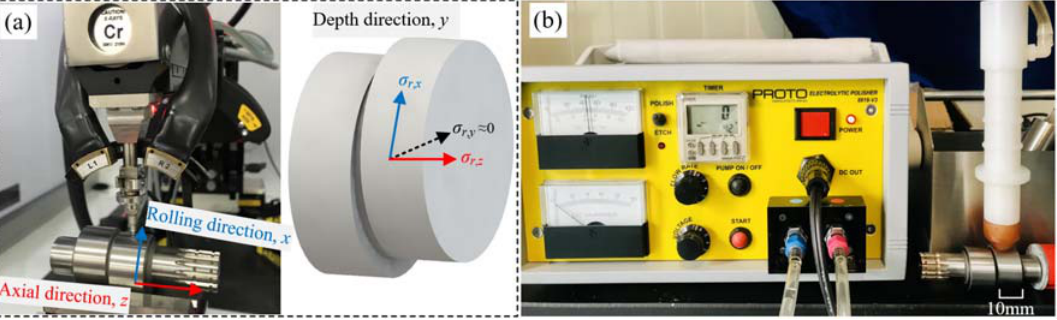
Figure 9. Residual stress measurement: ( a ) X ‐ ray diffractometer; ( b ) Electrolytic